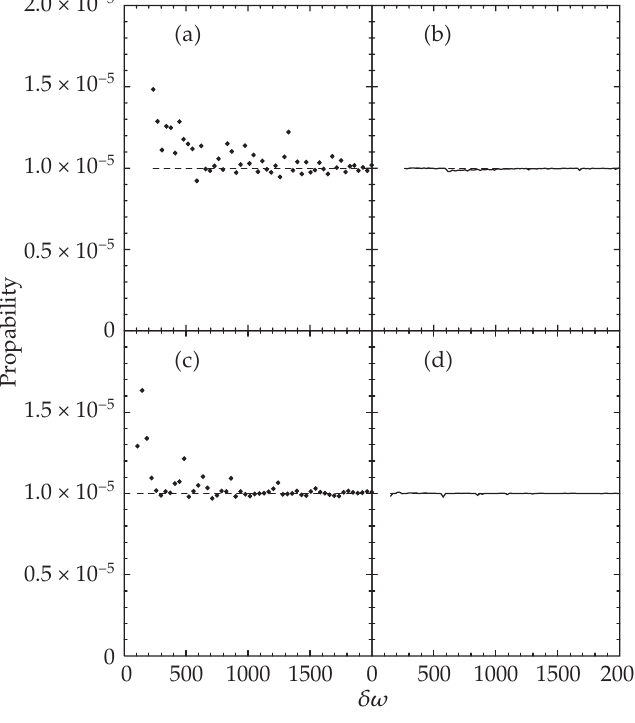
Figure 7.4 . The exact solution for the probability of generation of unwanted states P computed using the parameters which cor- respond to ( a ) dashed curve AB in Figure 7.1a ( obtained using ( 5.8 )) , ( b ) lower boundary of the hatched region in Figure 7.1a ob- tained using the improved perturbation theory, ( c ) dashed curve AB in Figure 7.1b ( obtained using ( 5.8 )) , ( d ) lower boundary of the hatched region in Figure 7.1b obtained using the improved pertur- bation theory. The dashed lines indicate the solutions obtained using ( corresponding ) perturbation theory for the same parameters.